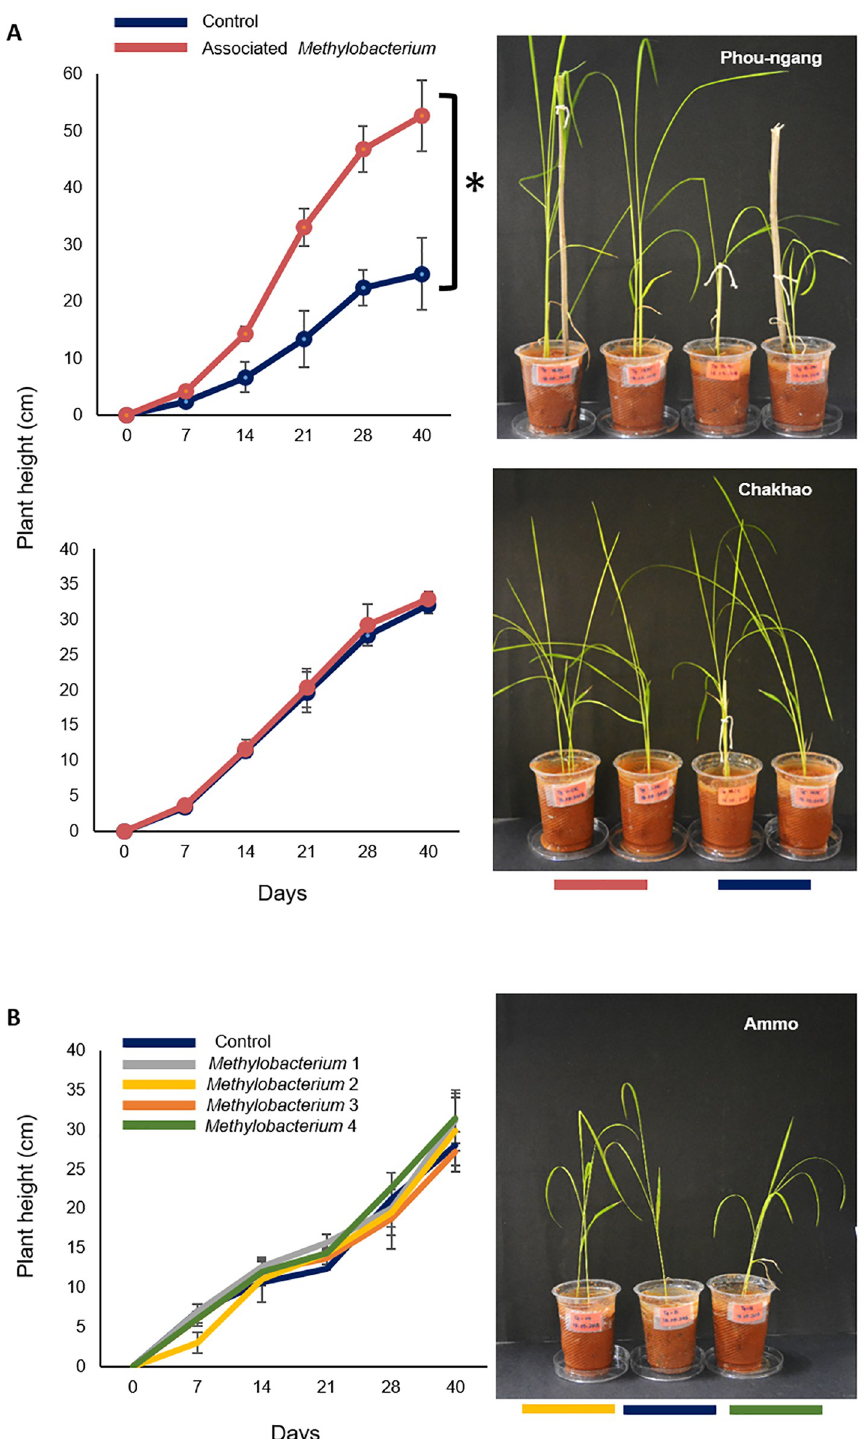
Fig 9. The effect of Methylobacterium on early growth of host rice landraces. Change in plant height (mean ± SD) over time, measured for (A) two different landraces inoculated either with their associated Methylobacterium strain or with bacterial growth medium (control) (B) plants from the landrace Ammo inoculated either with Methylobacterium isolated from various (other) landraces, or with bacterial growth medium (control). In both experiments, n = 3 plants / treatment. Arrows indicate the day on which plants were inoculated with the respective Methylobacterium strain (or growth media, for controls). Pictures show plant height on the last day of the experiment (day 40). https://doi.org/10.1371/journal.pone.0228550.g009 PLOS ONE | https://doi.org/10.1371/journal.pone.0228550 February 24,